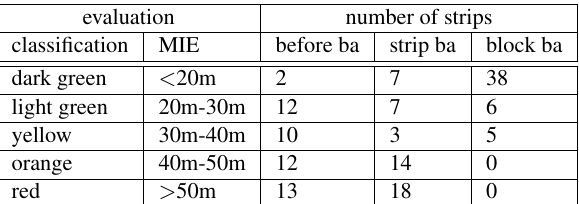
Table 2: Evaluation of the bundle adjustment (ba)